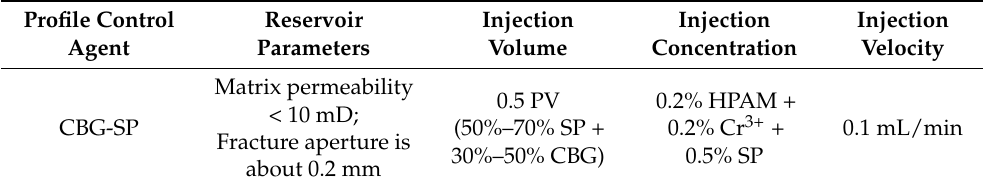
Table 10. Influence factors of CBG-SP in low-permeability fractured reservoirs.